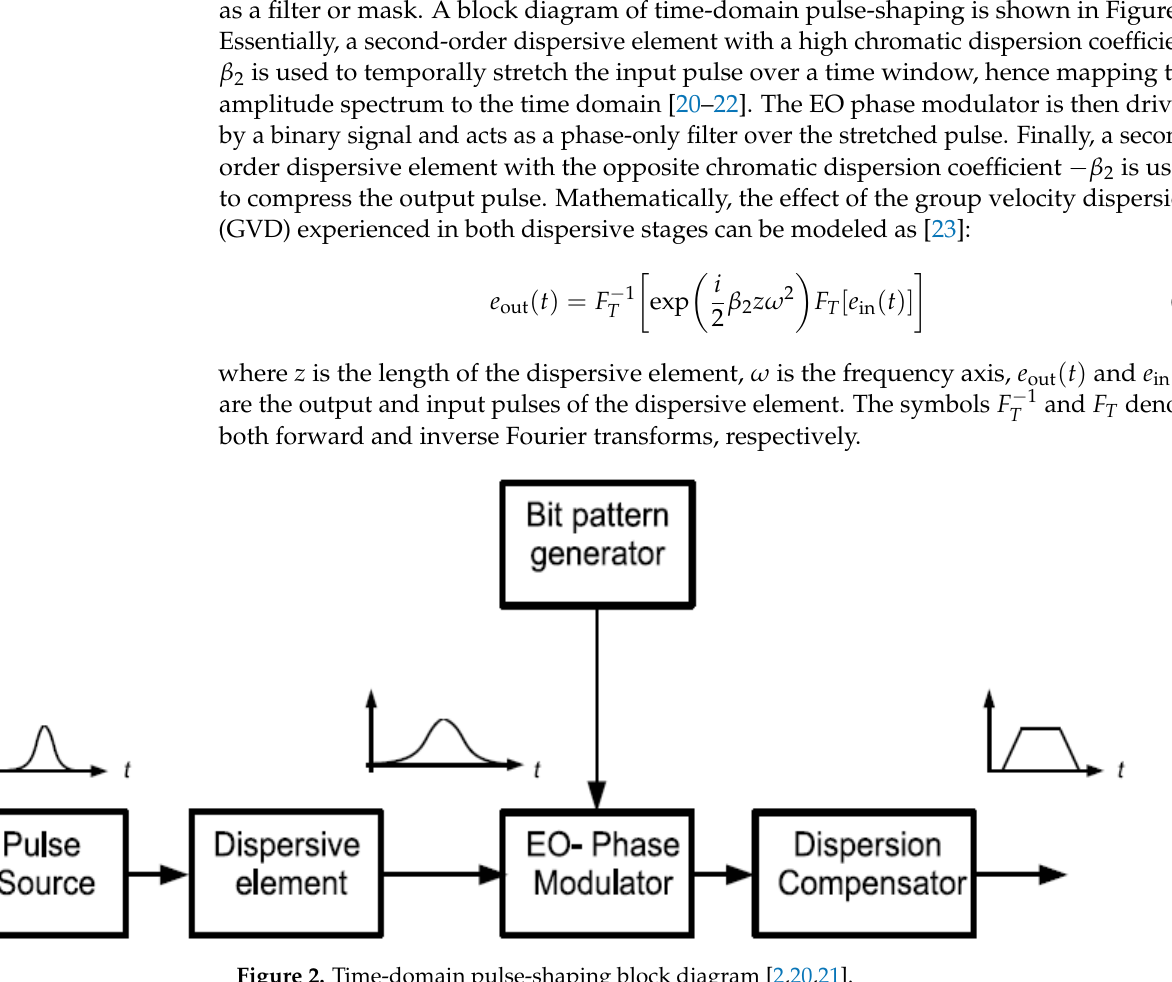
Figure 2. Time-domain pulse-shaping block diagram